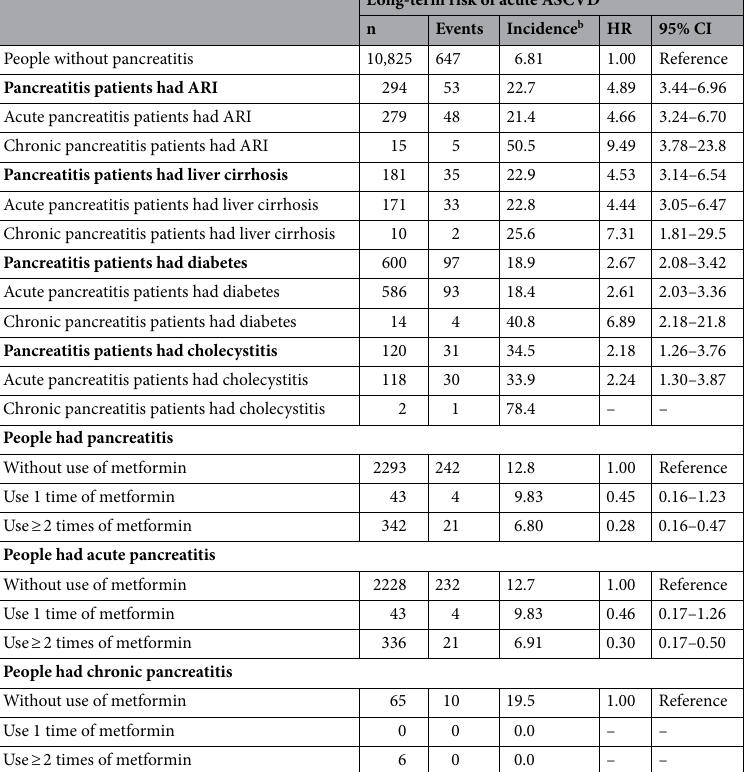
Table 3. The effects of medical conditions on long-term risk of acute ASCVD in patients with pancreatitis. ARI alcohol-related illness, ASCVD atherosclerotic cardiovascular disease, CI confidence interval, HR hazard ratio. a Adjusted for all covariates listed in Table 1. b Per 1000